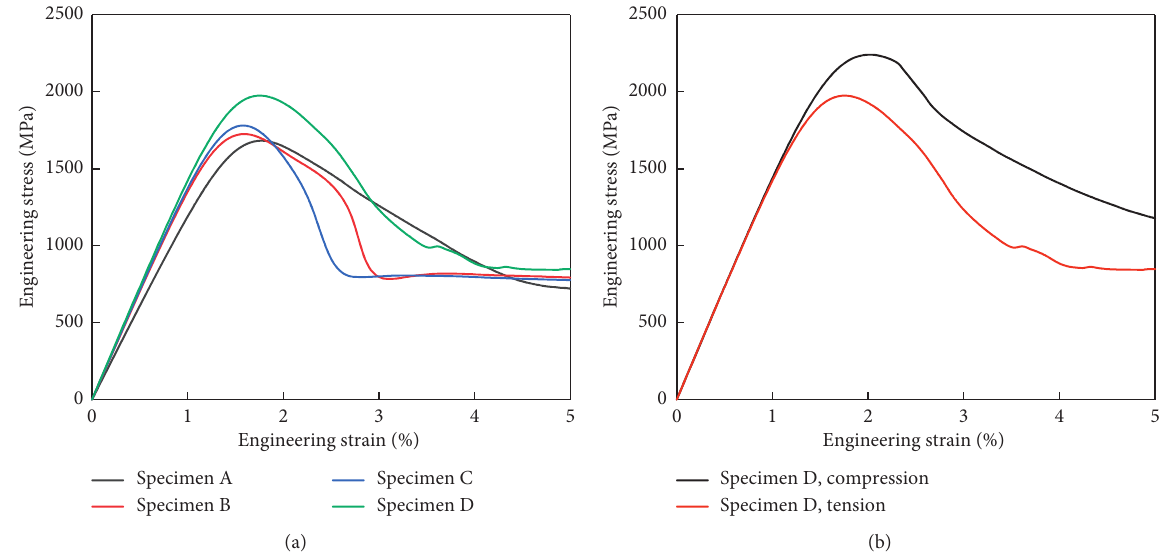
Figure 8: (a) Engineering stress-strain curves for specimens A–D under tensile loadings. (b) Comparison of simulations on specimen D in both tension and